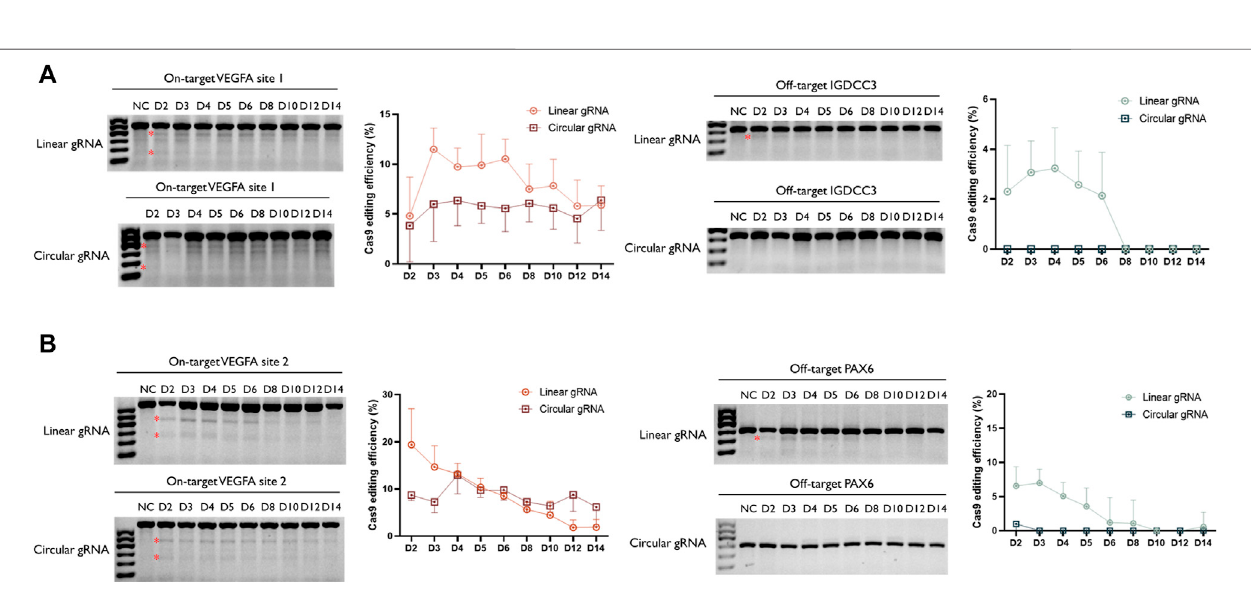
Frontiers in Cell and Developmental Biology |